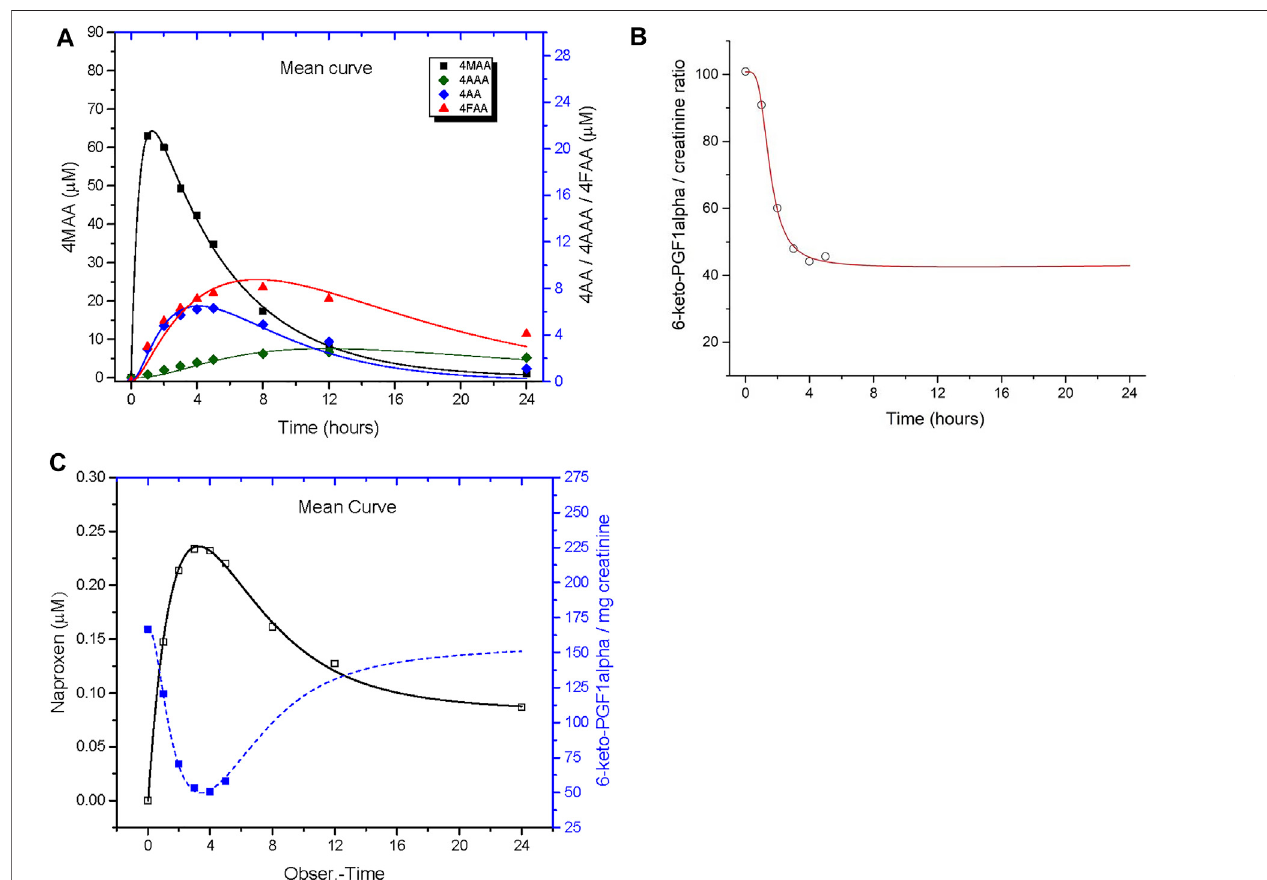
FIGURE6 | PKPD model output. Compartmental analysisof thepharmacokinetics and urinary 6-keto-PGF1 α excretion after single dose treatmentwith 1,000 mg metamizole (A,B) and 500 mg naproxen (C) . The model is described in the methods section and the model parameters are given in Table 3 . The individual fi ts are provided as supplementary